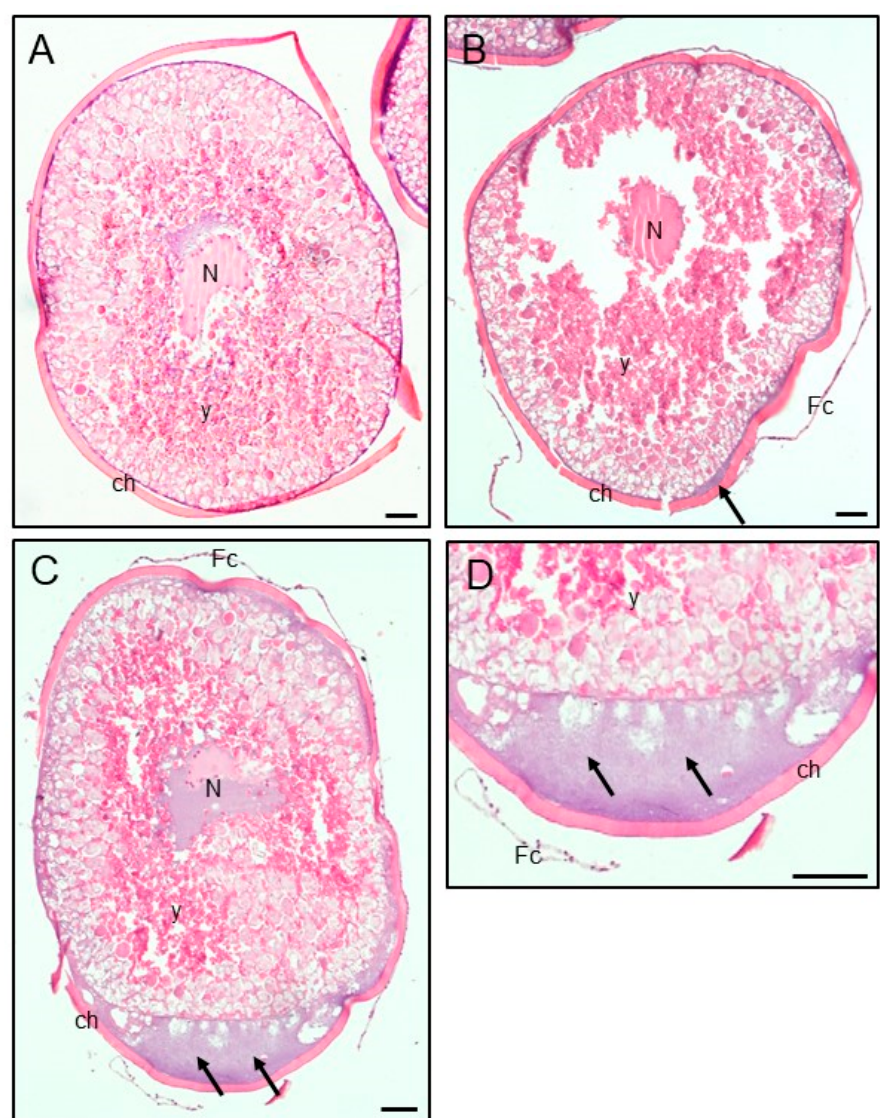
Figure 4. Morphological analysis of crucian carp ( Carassius carassius ) ovarian follicles from the control group ( A ) and those exposed to Roundup at a concentration of 1 ( B ) and 10 ng/mL ( C , D ). Arrows indicate the cytoplasm accumulated under the chorion that was more abundant following Roundup treatment ( B – D ) than in the control oocytes ( A ). Bar = 50 µ m ( A – D ) ch, chorion; Fc, follicular cells; N, nucleus; y, yolk.